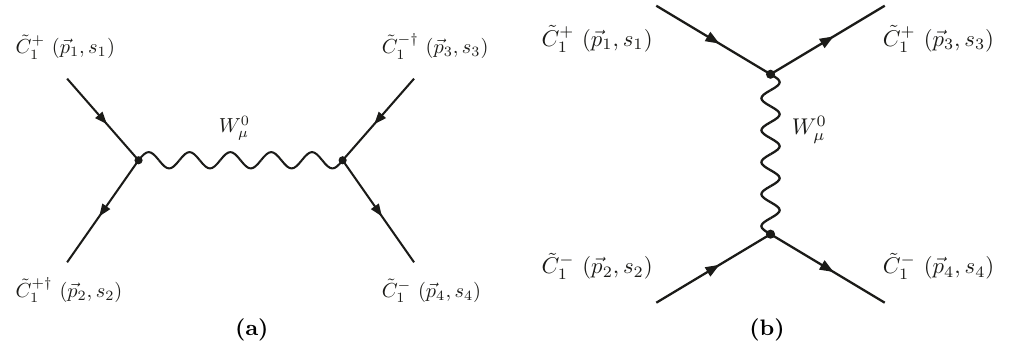
Figure 16. Sub(cid:12)gures (a) and (b) show some of the s - and t -channel diagrams respectively contributing to the ~ C +